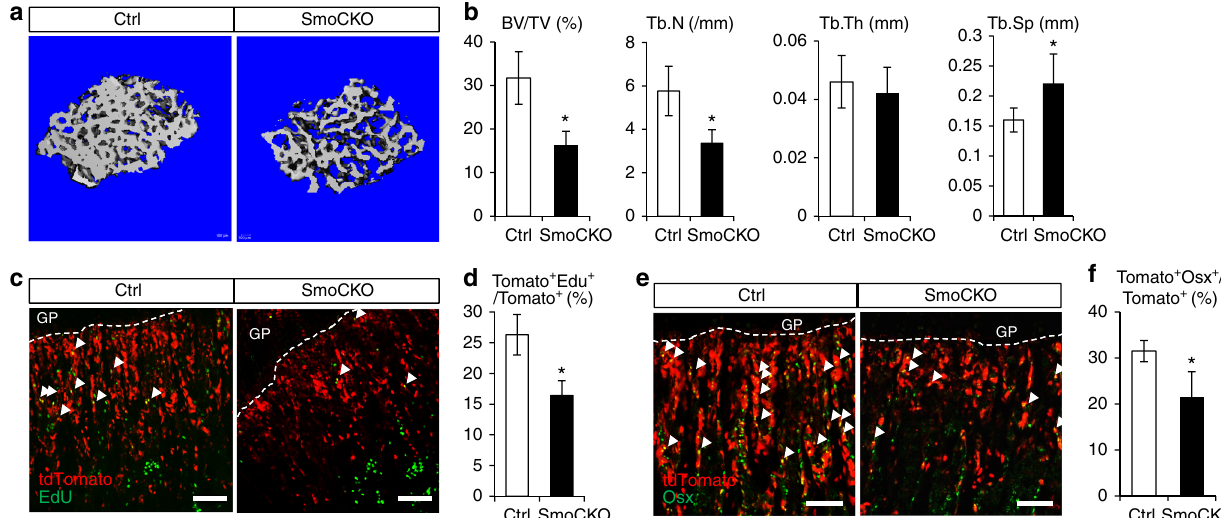
Fig. 5 Hh signaling is required for normal MMP proliferation and differentiation. Gli1-CreER T2 ;Ai9;Smo c/c (SmoCKO) or Gli1-CreER T2 ;Ai9 (Ctrl) mice treated with TM at 1 month of age and harvested after 10 days. GP growth plate. Scale bar: 100 µ m. a , b Representative images a or quanti fi cation of bone parameters b from µ CT analyses of cancellous bone region of distal femur. c EdU staining on sections of proximal tibia. Arrowheads indicate EdU + tdTomato + cells. d Percentage (mean ± SD) of EdU + tdTomato + over tdTomato + cells quanti fi ed within cancellous bone region extending 300 µ m from the growth plate of proximal tibia in two sections per mouse and three mice per genotype. e Immuno fl uorescence staining of Osx on sections of the proximal tibia. Arrowheads denote Osx + tdTomato + cells. f Percentage (mean ± SD) of Osx + tdTomato + over tdTomato + cells quanti fi ed within cancellous bone region extending 300 µ m from the growth plate of proximal tibia in two sections per mouse and three mice per genotype. * p < 0.05, n = 3, paired Student's